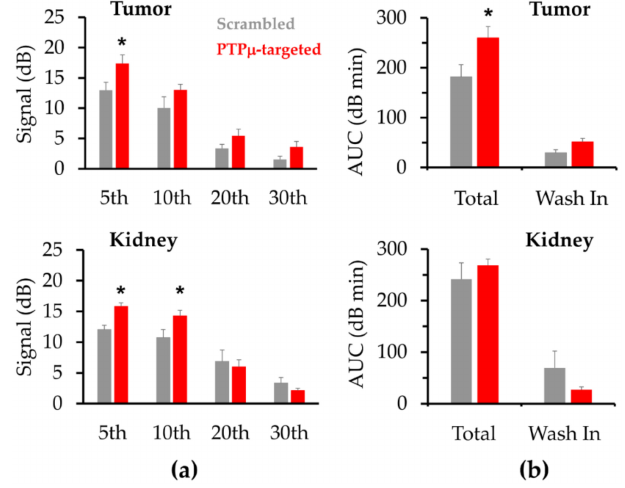
Figure 4. PTP µ -targeted NBs show greater contrast in tumors and are retained longer than Scrambled NBs. ( a ) The mean ± standard error (SE) signal intensity was calculated from the 12 echo power measurements collected for each 1-minute increment for the data represented as time intensity curves (TICs) in 3b. In tumor, the US signal produced by PTP µ -targeted NBs was significantly greater than that of the Scrambled NBs during the 5th through 7th minute increments. In kidney, the US signal produced by PTP µ -targeted NB was significantly greater than that of the Scrambled NBs from the 3rd through 10th minute increments. ( b ) Area under the curve (AUC) parameters obtained from the TICs shown in 3b. In tumor, PTP µ -targeted NBs had significantly higher total and AUC wash-in compared to Scrambled NBs. In kidney, total AUC and AUC wash-in were not significantly different between PTP µ -targeted NB and Scrambled NBs. Bars represent the mean ± SE of the AUC type indicated, (* p <